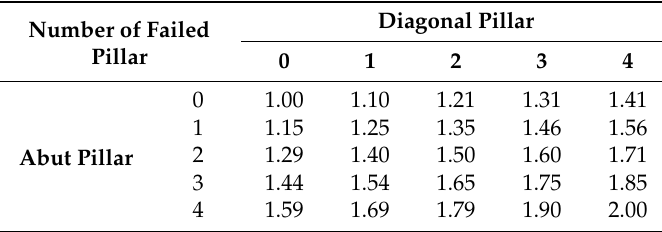
Table 6. The initial safety factor for a stable pillar after its neighboring pillars all fail.